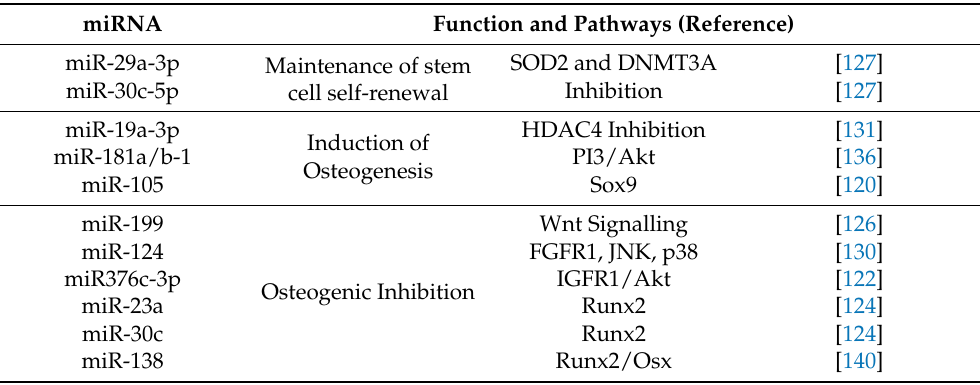
Table 3. Summary of miRNA implicated in MSC and skeletal tissue aging and